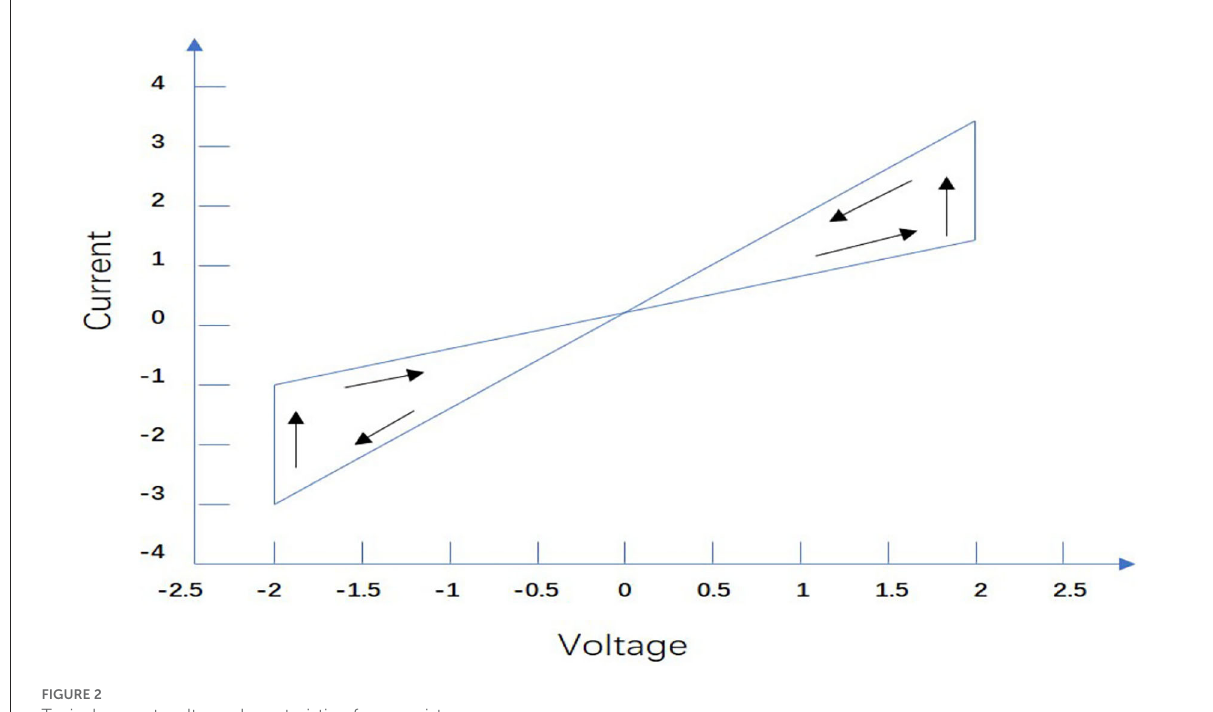
FIGURE2 Typical current-voltage characteristic of a